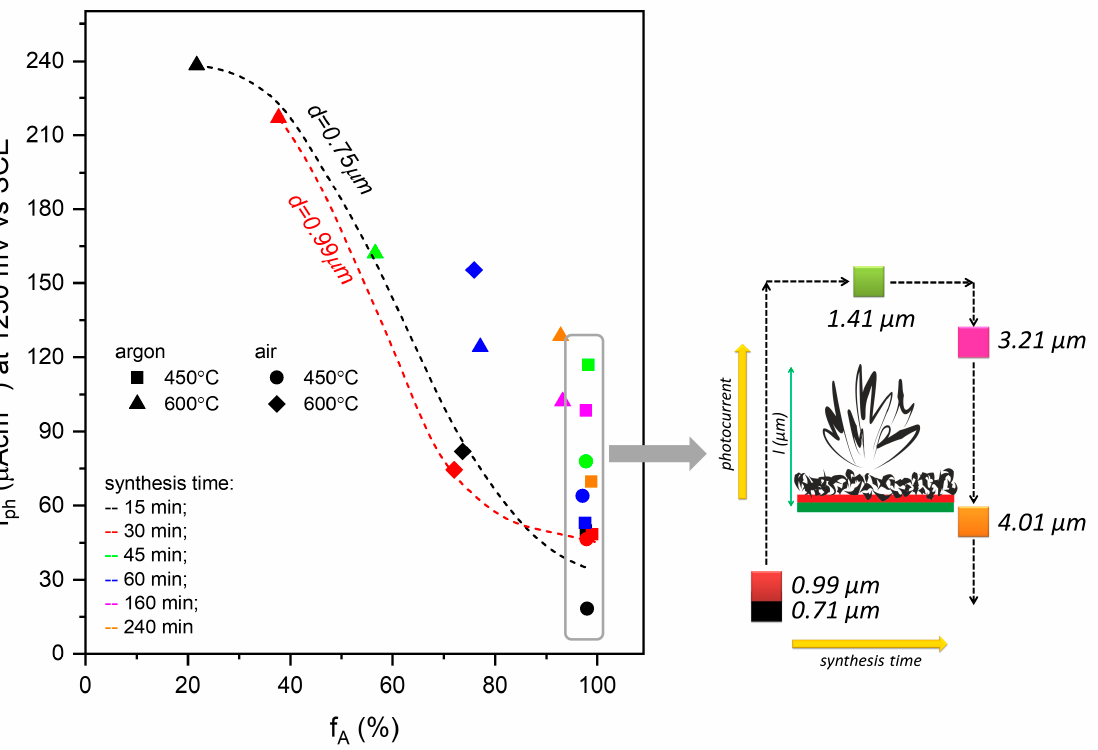
Figure 8. The photocurrent at 1250 mV vs anatase fraction f A for different flower-like TiO 2 pho-